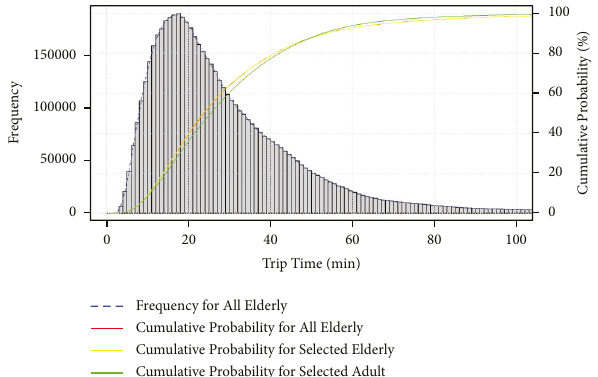
Figure 2: Frequency distribution of the metro-based trip time.